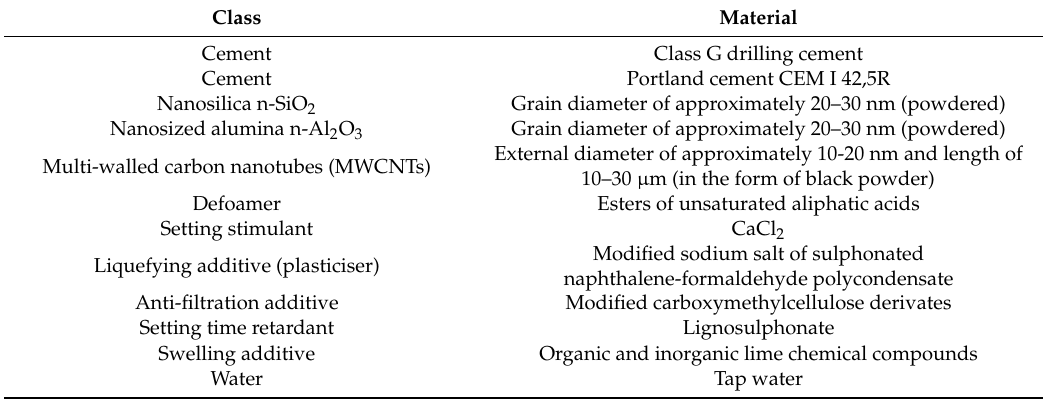
Table 2. Materials used in composition of the oil-well cement